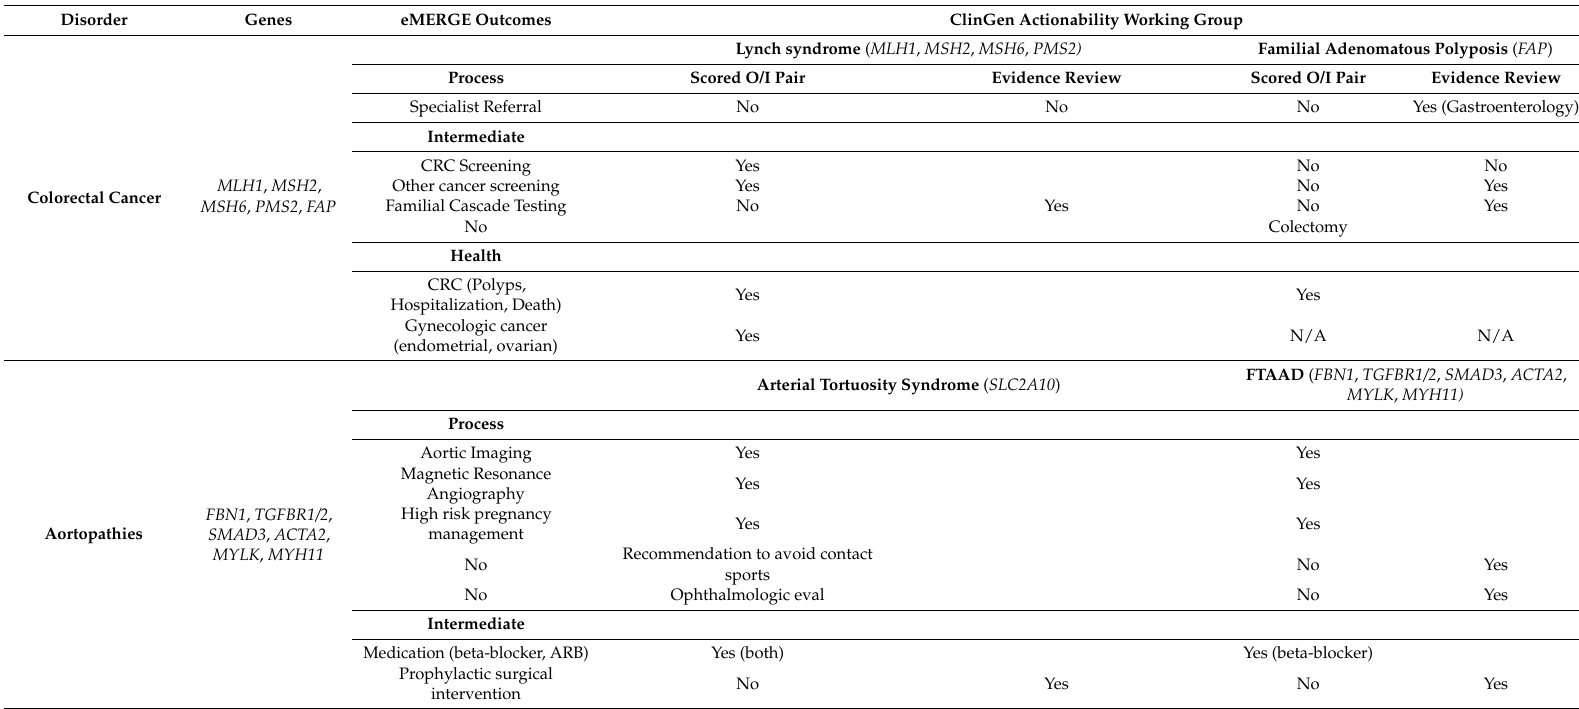
Table 3. Disorders with differing definitions between eMERGE and